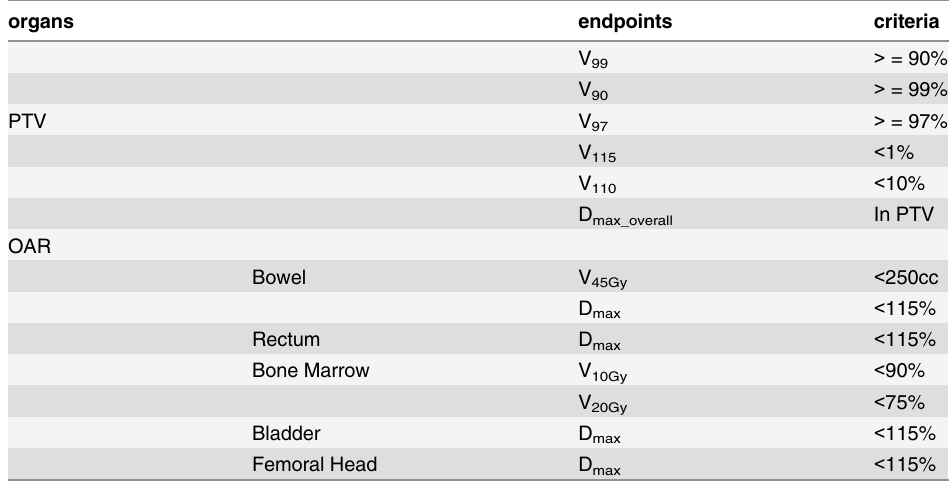
Table 1. Dosimetric endpoints and criteria for assessing IMRT plan quality.